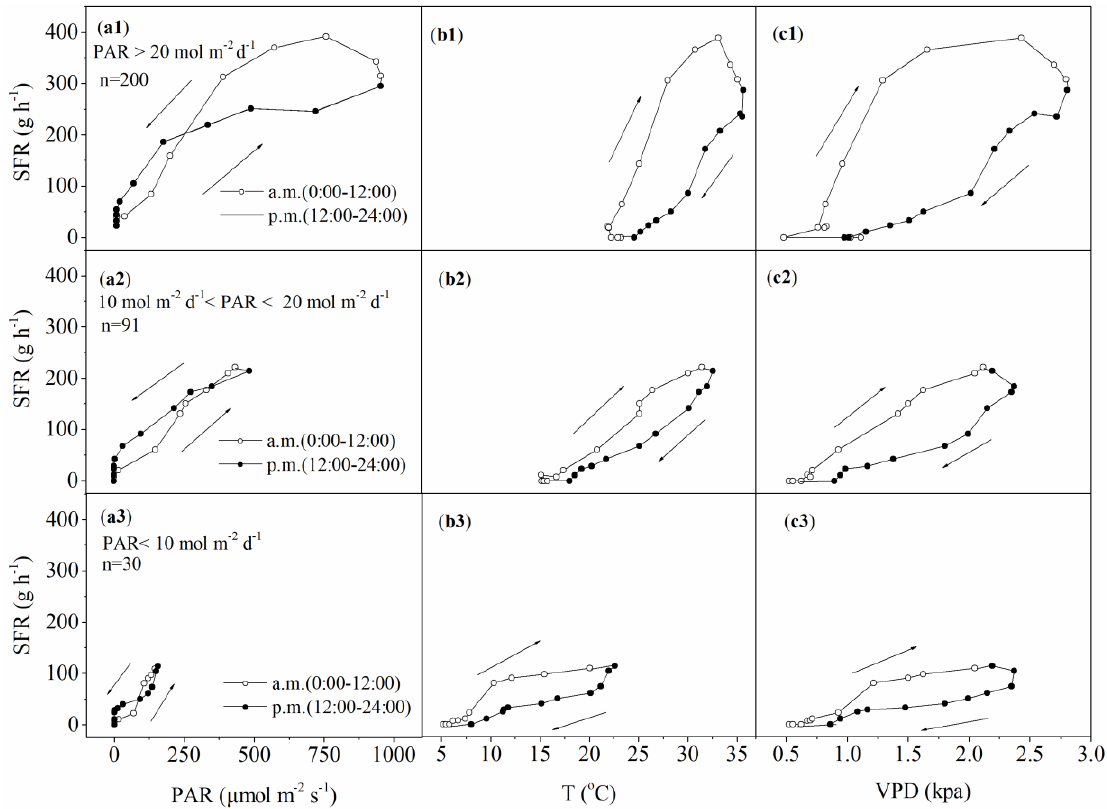
Figure 8. Changes in daily cycle of hourly mean sap flow rate (SFR) for ( a ) photosynthetically active radiation (PAR), ( b ) air temperature (T) and ( c ) vapor pressure deficit (VPD) in a day, for sunny (PAR > 20 mol m − 2 d − 1 , ( a1 , b1 , c1 )), cloudy (10 mol m − 2 d − 1 < PAR < 20 mol m − 2 d − 1 , ( a2 , b2 , c2 )), and rainy (PAR < 10 mol m − 2 d − 1 , ( a3 , b3 , c3 )) days in 2017 and 2018 experimental periods. Note that arrow denotes direction of change with time and n denotes number of days with corresponding typical climatic conditions.